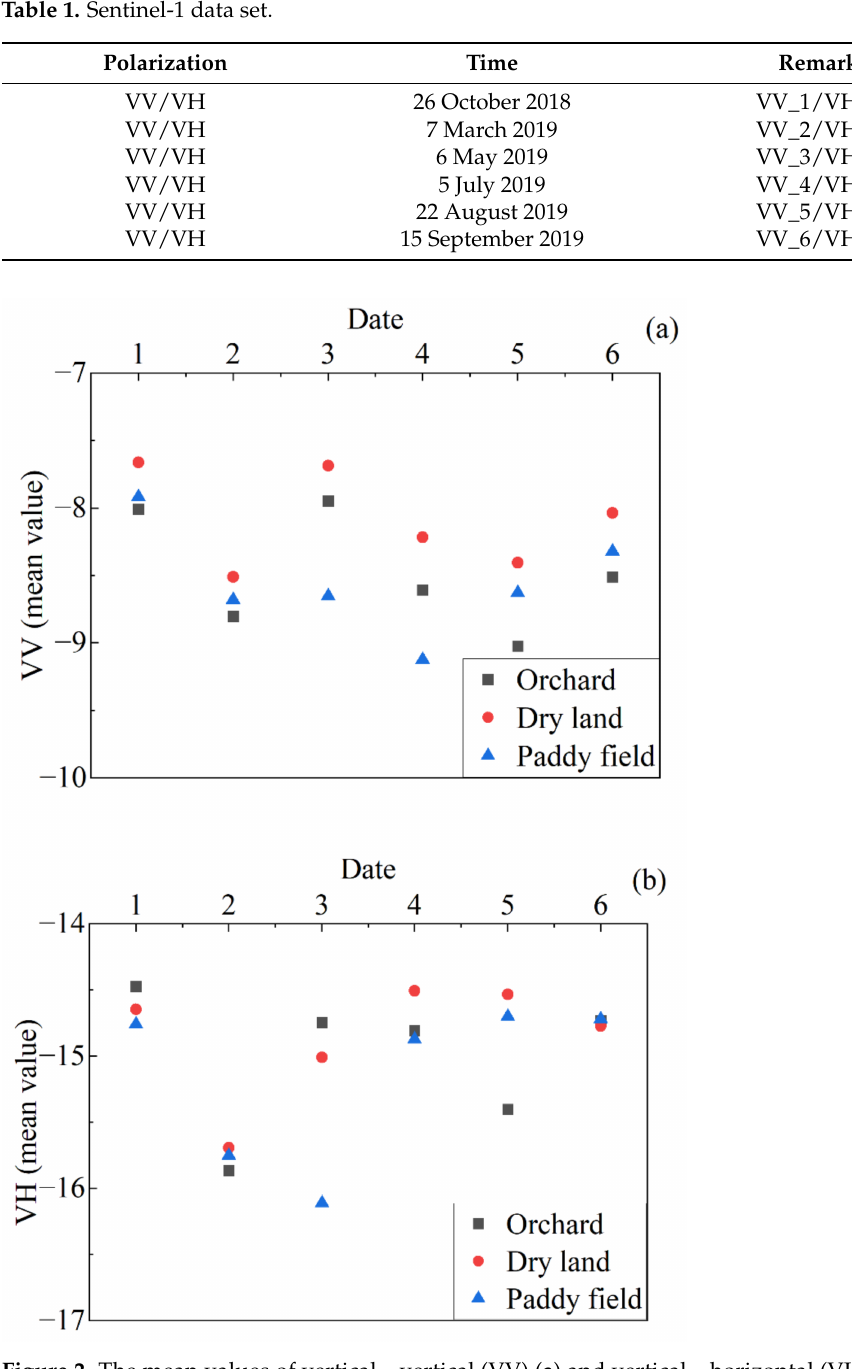
Figure 2. The mean values of vertical—vertical (VV) ( a ) and vertical—horizontal (VH) ( b ) of SAR satellite imagery (Sentinel-1) at six time points; 1, 2, 3, 4, 5, and 6 in the abscissa represent the times, which are 26 October 2018, 7 March 2019, 6 May 2019, 5 July 2019, 22 August 2019, and 15 September 2019,